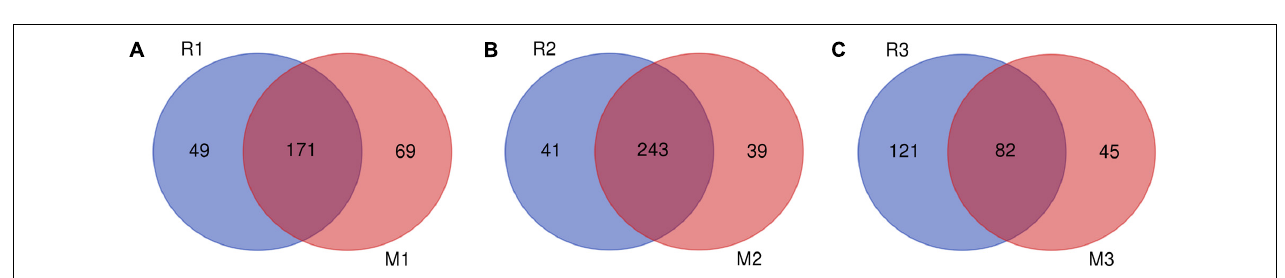
FIGURE 6 | Venn diagram of bacterial community OTUs of C. medinalis fed different host plants for three generations. M1–M3: the first to third generation of C. medinalis fed on maize; R1–R3: the first to third generation of C. medinalis fed on rice. (A) M1 vs. R1; (B) M2 vs. R2; (C) M3 vs. R3.